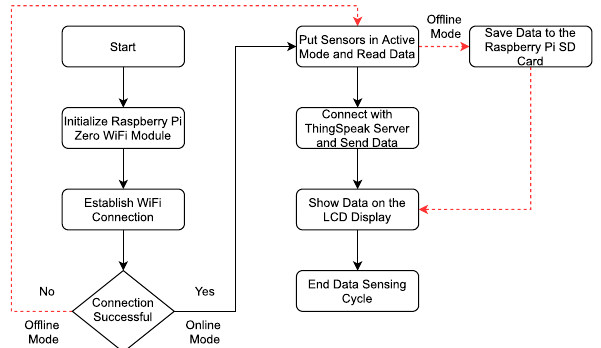
Figure 5. Flowchart of CoSense Unit